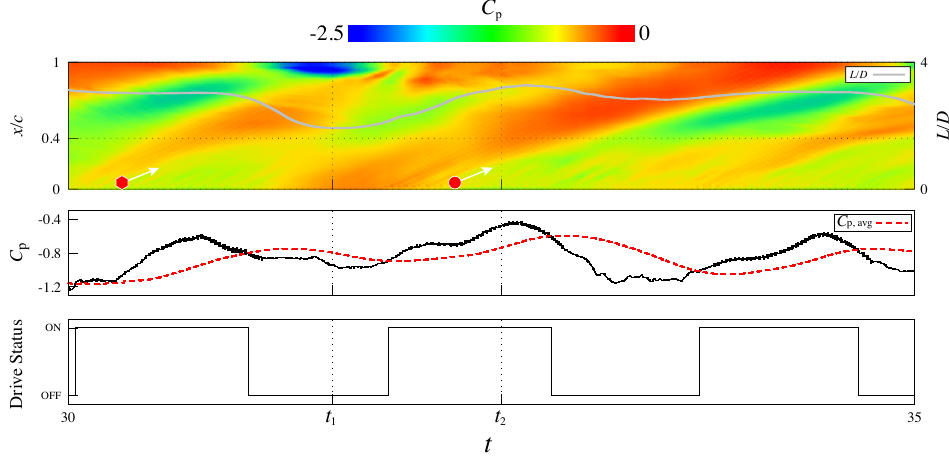
Figure 21. The time histories of L / D , C p,var at the pressure sensor and the drive status of the plasma actuator in FTM4 from top to bottom. The top figure overlaps with the distribution of the spanwise- averaged C p on the upper surface of the airfoil in the x / c - t domain. The red symbols and arrows represent the characteristic vortex positions and their